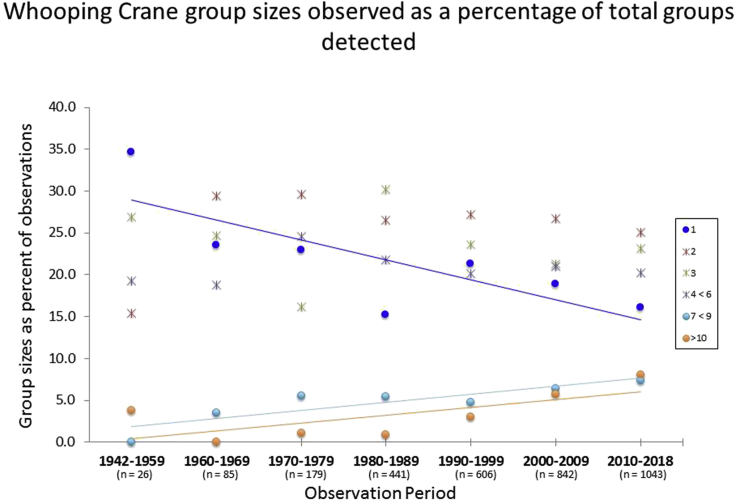
Whooping Crane group sizes observed as a percentage of total groups detected on a decadal time scale. Group sizes exhibiting a significant trend in proportional occurrence are fit with least squares linear regression lines (navy blue line = individual Whooping Cranes, sky blue line = groups of seven to nine, and orange = groups of 10 or more).